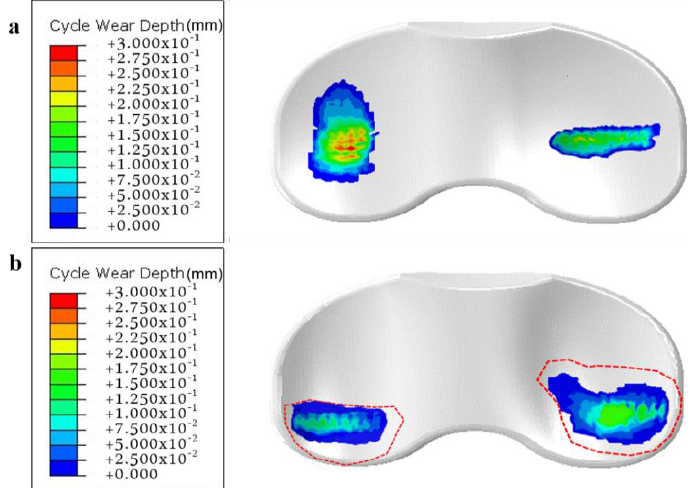
Figure 7. Computational wear contour after 5 million cycles: ( a ) initial model; ( b ) optimal